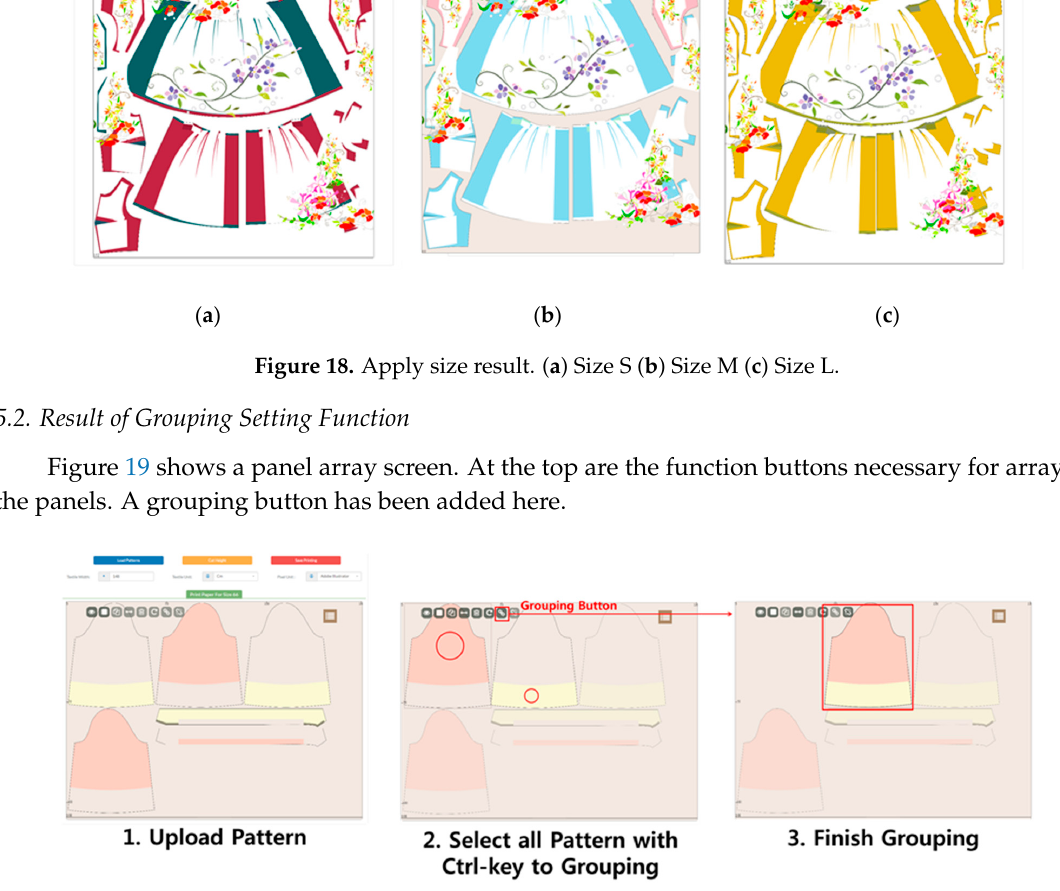
Figure 19. Result of grouping setting function.